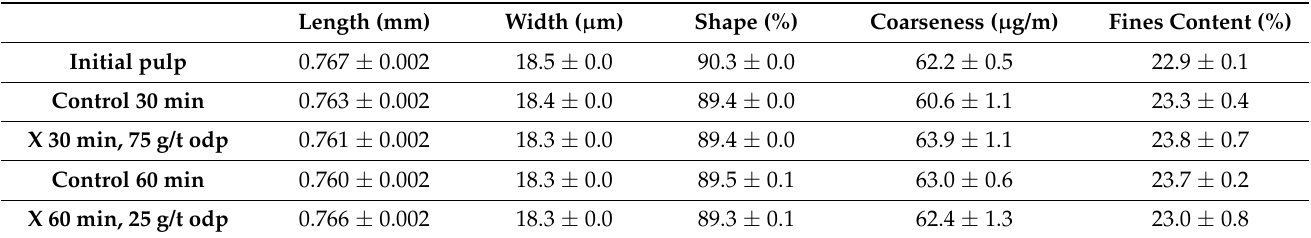
Table 1. Average fibre morphology properties after X and control treatments of oxygen-delignified eucalypt kraft